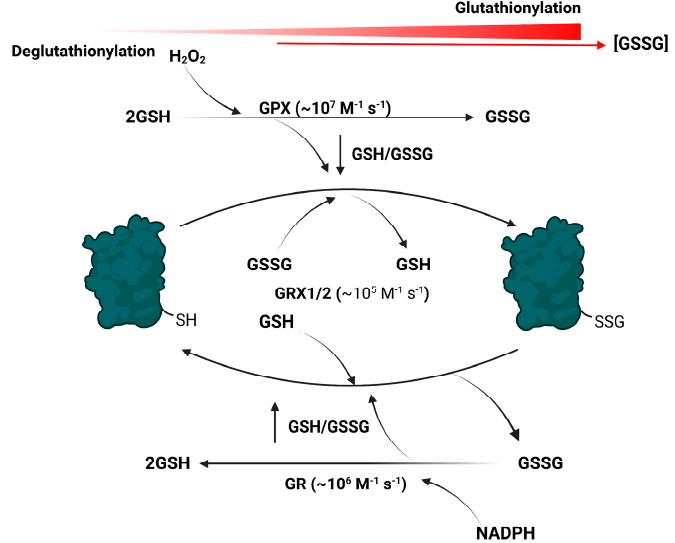
Figure 1. The addition and removal of glutathione to and from target proteins is a rapid event that occurs in response to spatiotemporal fluctuations in GSH and GSSG availability. Cell nutrient metabolism and electron release from various enzymes (e.g., flavin-dependent dehydrogenases) causes the rapid production of H 2 O 2 and its clearance by glutathione peroxidases (GPX). This results in the oxidation of the glutathione pool and a decrease in the GSH/GSSG ratio. The forward glutathionylation reaction is driven by glutaredoxins (GRX1; cytoplasm and intermembrane space, GRX2; matrix) in response to glutathione pool oxidation. Production of NADPH by the same nutrient oxidizing pathways that generate H 2 O 2 is used by glutathione reductases (GR) to reduce the disulfide bridge